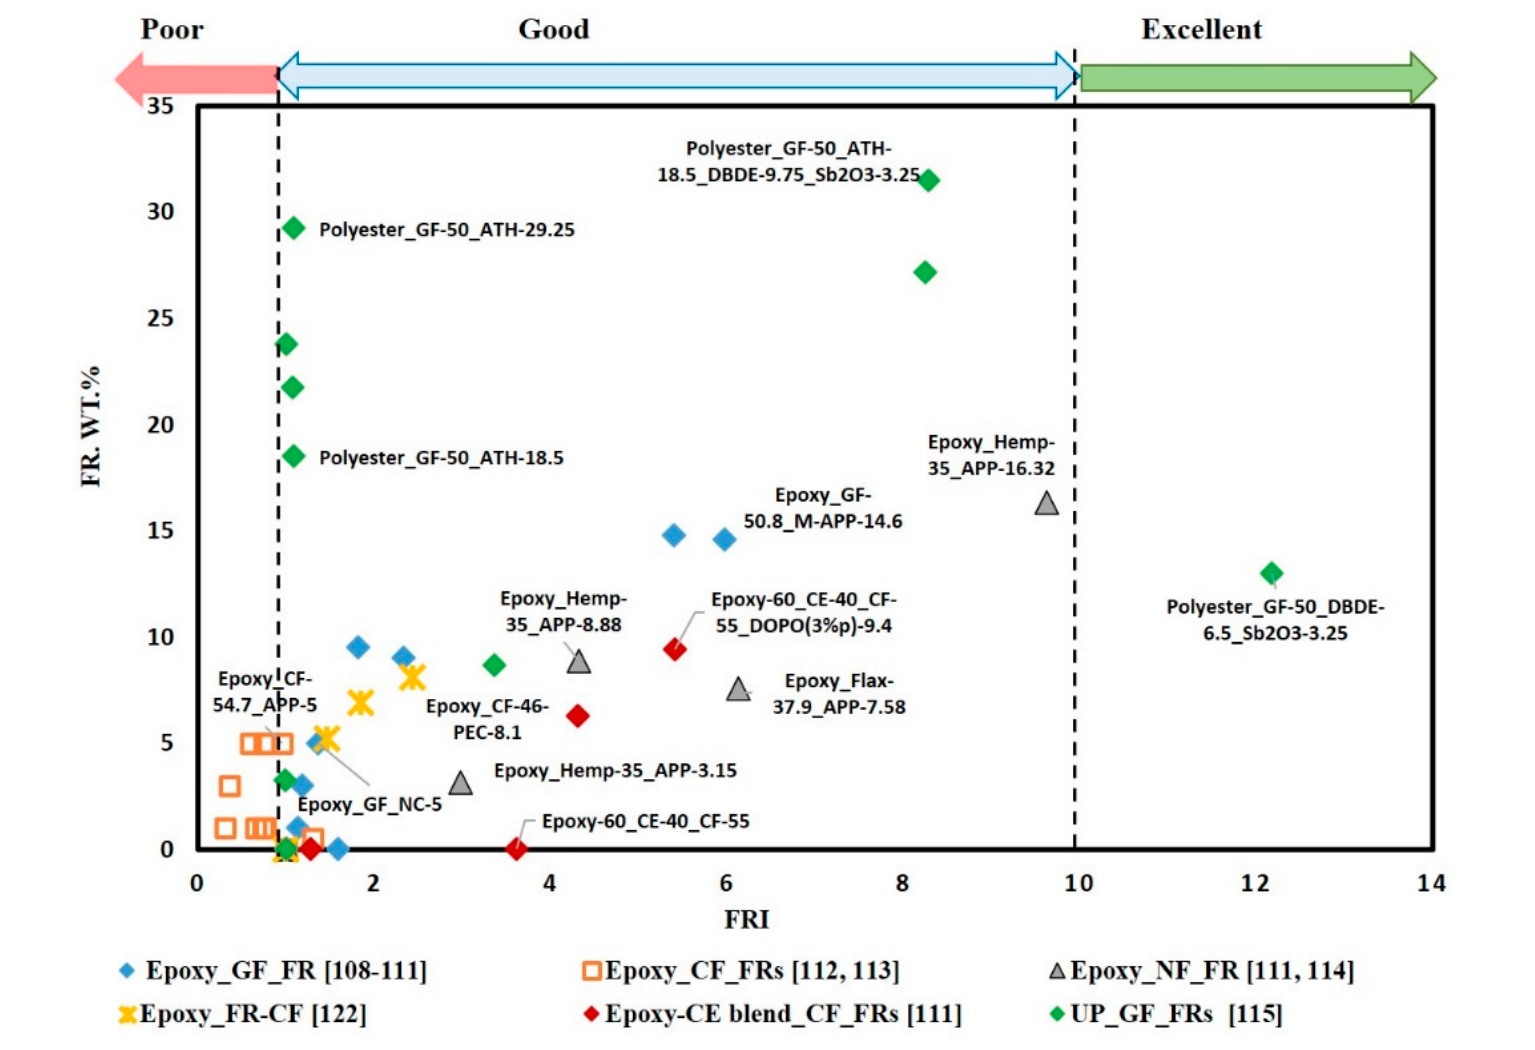
Figure 12. Flame retardancy index (FRI) for different FR/composite systems with respect to weight content of FR.